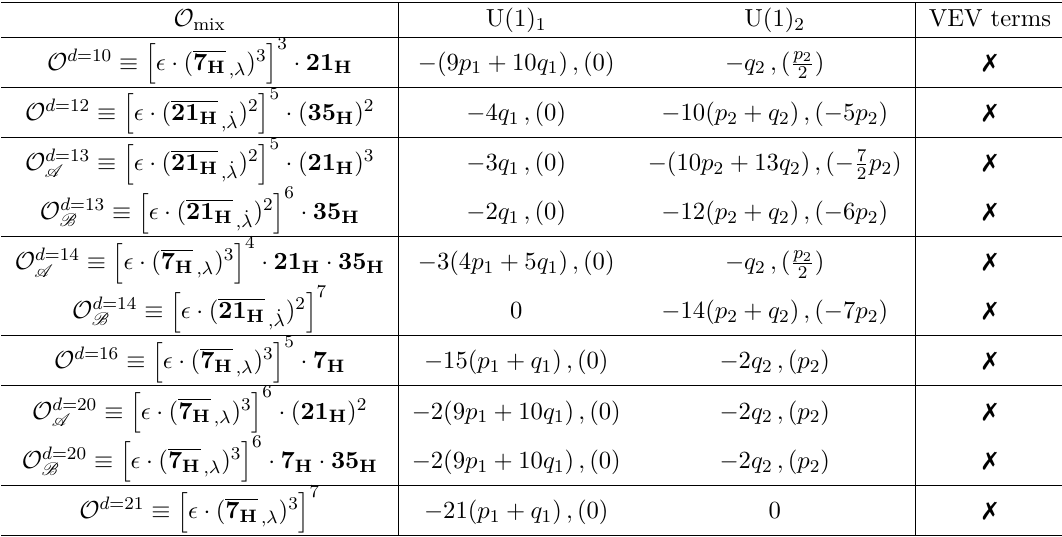
Table 14 . The non-renormalizable SU(7) Higgs mixing operators with d ≥ 10 and their U(1) 1 , 2 charges. The 3 and 7 represent whether the specific operator can contribute to VEV terms in the Higgs potential or not. The charge assignments with p in